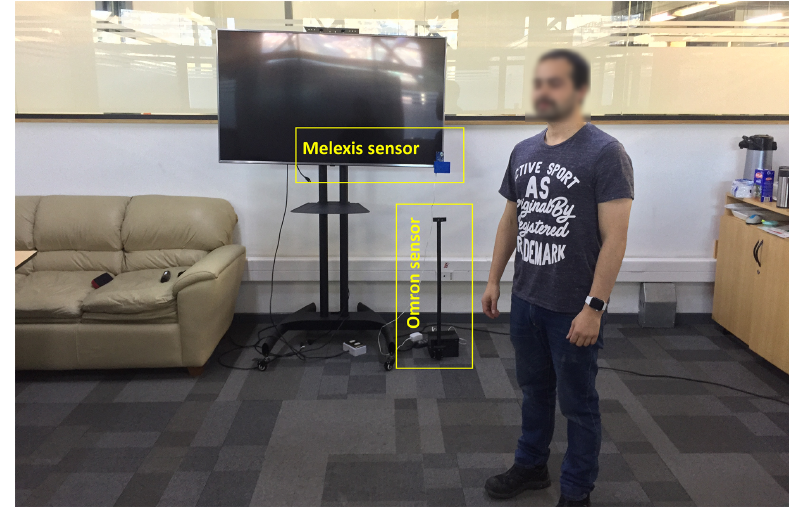
Figure 4. Laboratory where the experiments were